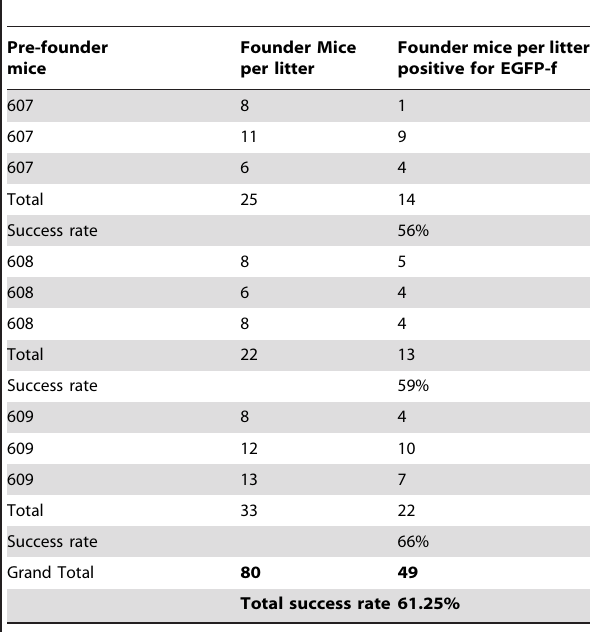
Table 1. Percentage of EGFP-f positive pups obtained from individual matings with three different pre-founder